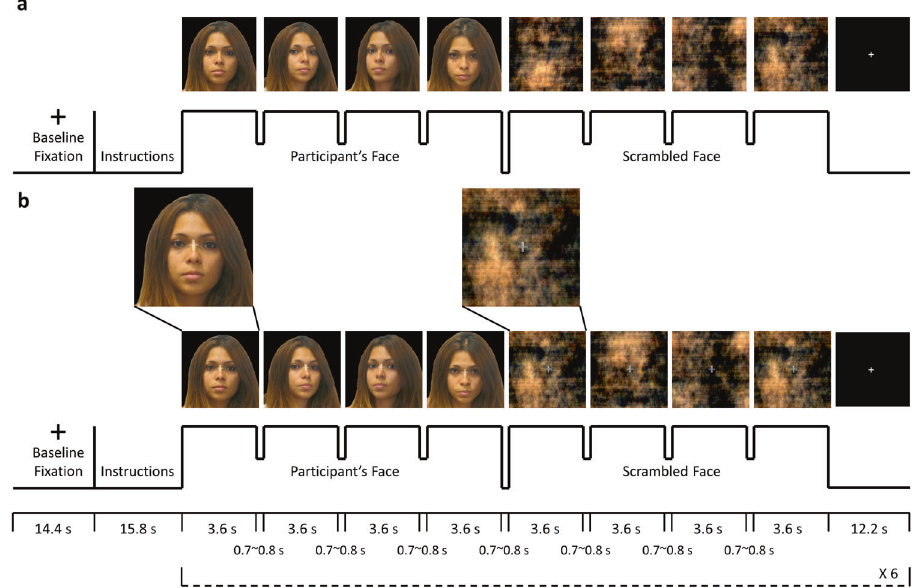
Fig. 1 fMRI task paradigm. Four color photos of participants ’ own faces at different, standardized angles were captured before the MRI session. A blocked design was used for the presentation of participant ’ s own face and scrambled face control stimuli for both ( a ) natural viewing and ( b ) visual modulation runs. The fi rst 4 images were participant ’ s faces at different angles, and the next four images were scrambled faces. Each image was presented for 3.6 s, with a brief gap of 0.7~0.8 s for changing the image. A fi xation with duration of 12.2 s was shown after the stimuli. The presentation of participant ’ s face and scrambled face stimuli was repeated six times in a single run. The stimuli for the visual modulation run ( b ) had a semi-transparent crosshair between the eyes of the participants ’ faces and in the center of the scrambled faces. For the visual modulation run, participants were required to maintain their gaze on the crosshair. The rationale was that fi xating visual gaze on the crosshair would reduce scanning associated with piecemeal/detailed processing, and enhance holistic/global visual processing. To ensure task compliance for viewing the photos and crosshairs, gaze location was continuously monitored with the camera by the experimenters during the scan. Informed consent was obtained for publication of the image for the volunteer in the fi